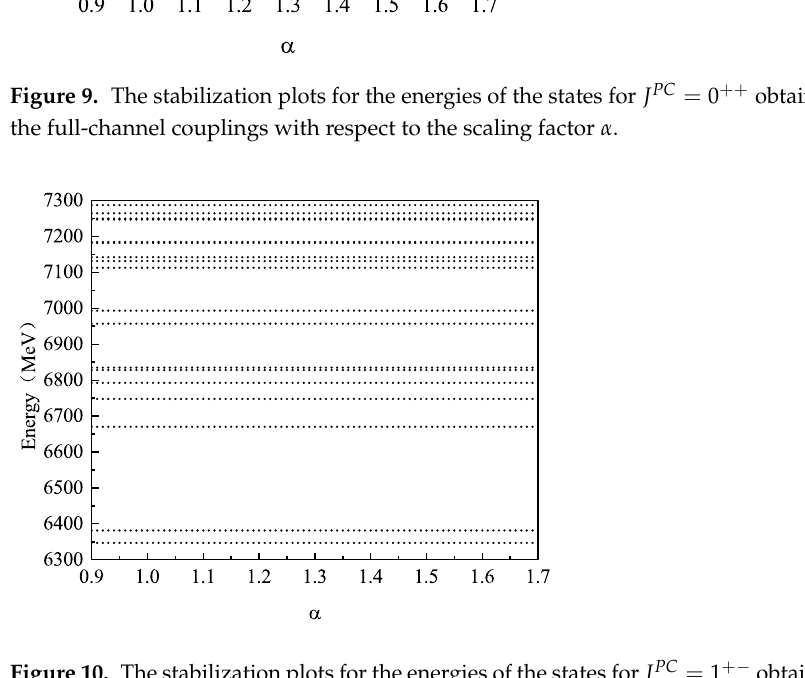
Figure 10. The stabilization plots for the energies of the states for J PC = 1 + − obtained by considering the full hidden-channels coupling with respect to the scaling factor α